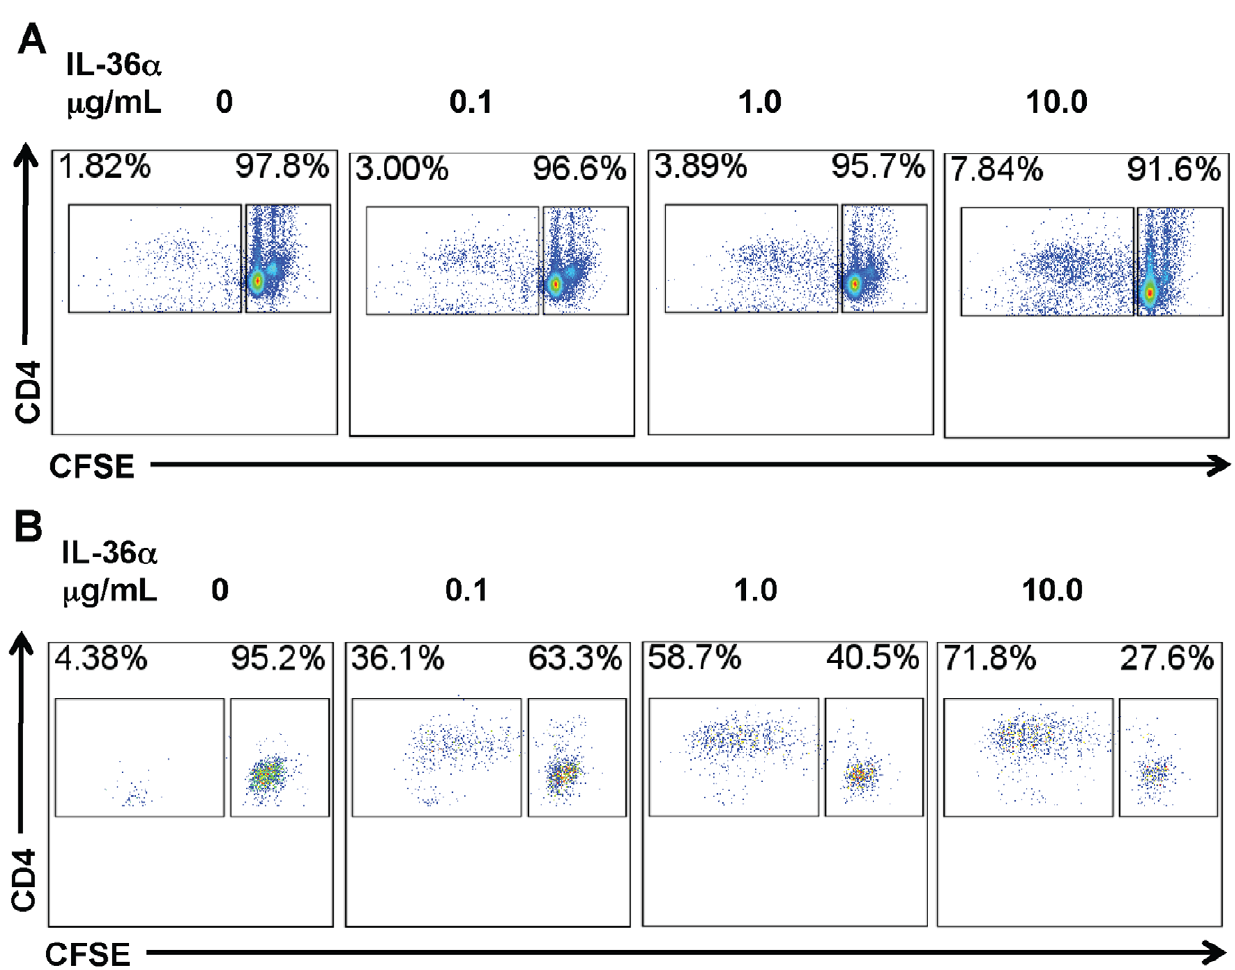
Figure 8. Incubation with IL-36 a enhances the ability of splenic CD11c + cell mediated CD4 + T cell proliferation. A) Flow cytometric evaluation of CD4 + T cell proliferation responses induced by IL-36 a stimulated splenic CD11c + cells. Splenic CD11c + cells were incubated with increasing doses of IL-36 a for 2 h. Following incubation, media containing IL-36 a was removed and CFSE-labeled CD4 + T cells were co-cultured with IL-36 a stimulated CD11c + cells. CFSE dilution was used to evaluate T cell proliferation responses 96 h following co-culture. CD4 + T cell proliferation was proportional to the concentration of IL-36 a used for stimulating CD11c + cells used in the co-culture. Flow cytometry plot presented is representative of quadruplicate samples in one out of two independent experiments. B) Flow cytometric evaluation of antigen-specific CD4 + T cell proliferation responses induced by IL-36 a stimulated splenic CD11c + cells. Splenic CD11c + cells were incubated with increasing doses of IL-36 a and 100 ng/mL OVA 323-339 for 2 h. Following incubation, media containing IL-36 a and the OVA peptide was removed and CFSE-labeled CD4 + T cells from OTII TCR transgenic mice were co-cultured with IL-36 a stimulated, OVA peptide pulsed CD11c + cells. CFSE dilution in the culture was used to evaluate T cell proliferation responses 96 h following co-culture. CD4 + T cell proliferation was proportional to the concentration of IL-36 a used for stimulating CD11c + cells used in the co-culture. Flow cytometry plot presented is representative of quadruplicate samples in one out of two independent experiments.